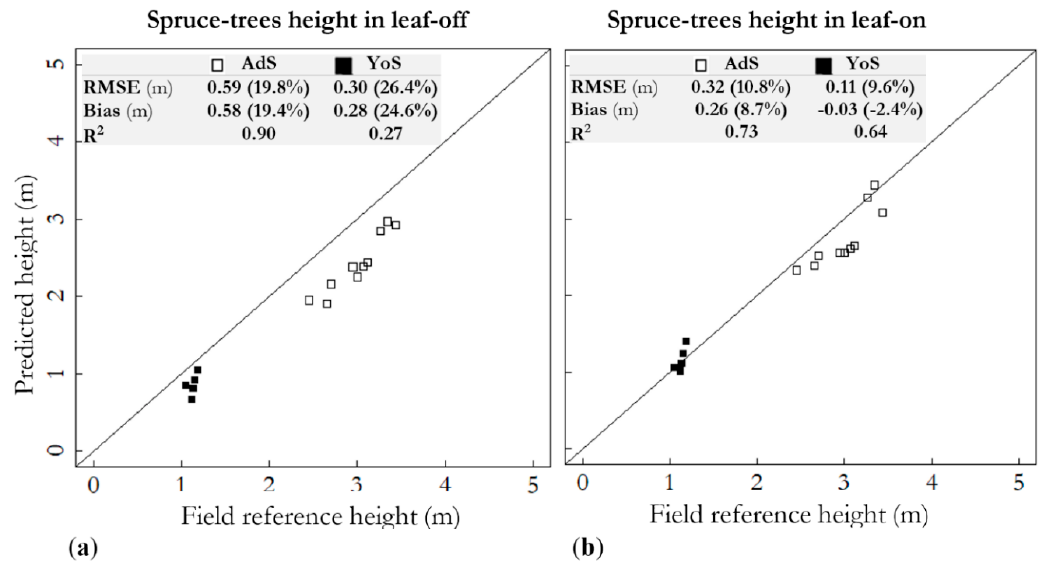
Figure 6. Spruce-specific mean tree height (unit: meter) in leaf-off ( a ) and leaf-on ( b ) conditions, separating plots in advanced seedling stand (AdS) and plots in young seedling stand (YoS) in leaf-off and leaf-on conditions.